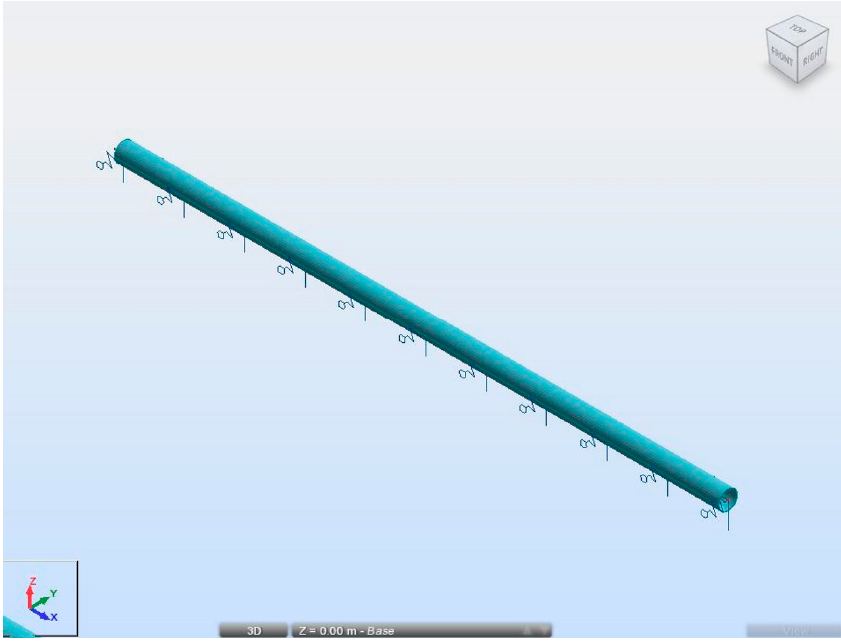
Figure 6. Calculation model for pipes.